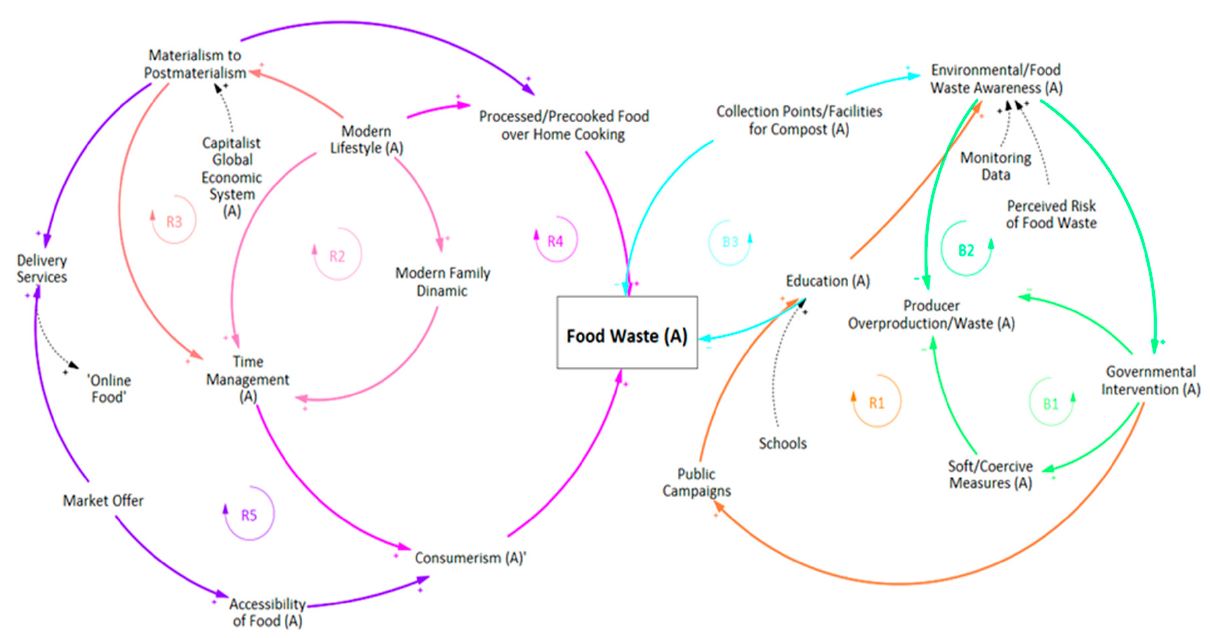
Figure A2. Food waste loop diagram elaborated during modeling session with the representative of the public administration (each color highlights a distinct loop).